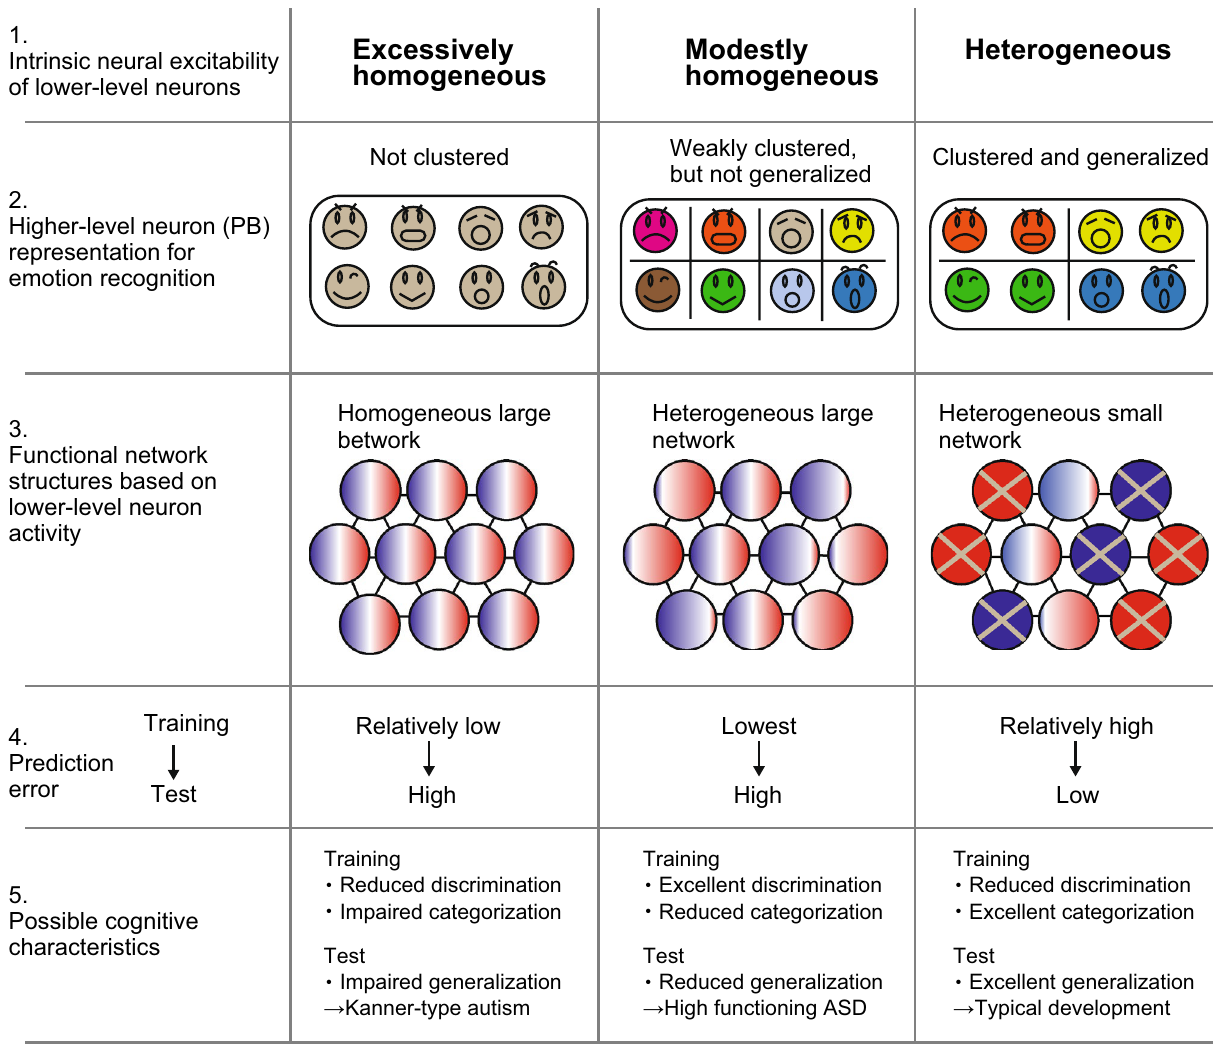
Figure 6. The summary of characteristics of neural networks with different neural excitability. The first row shows the names of representative network models with different intrinsic neural excitability of lower-level neurons (Table 1). The second row shows the higher-level neuron representation for emotion recognition. The 8 facial expression symbols, which can be categorized into 4 basic emotions, are shown as examples. The color represents the categorized groups by each network model. The third row shows the functional network structures in lower-level neurons. The circle represents each neuron. The color gradation in the circle represents the range of activity, and cross marks in the circle indicate that the range of activity in particular neuron is nearly zero (i.e., neurons whose activities are not changing). The fourth rows shows the prediction error in training and test datasets. The fifth rows illustrates possible cognitive characteristics and subtypes of autism spectrum disorder corresponding to each network